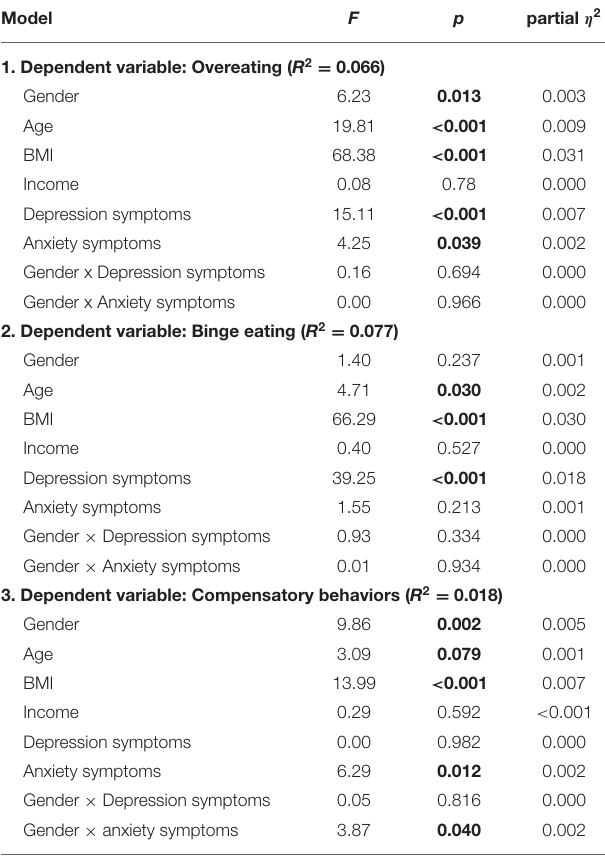
TABLE 4 | Results of the General linear models of diagnostically relevant behaviors.